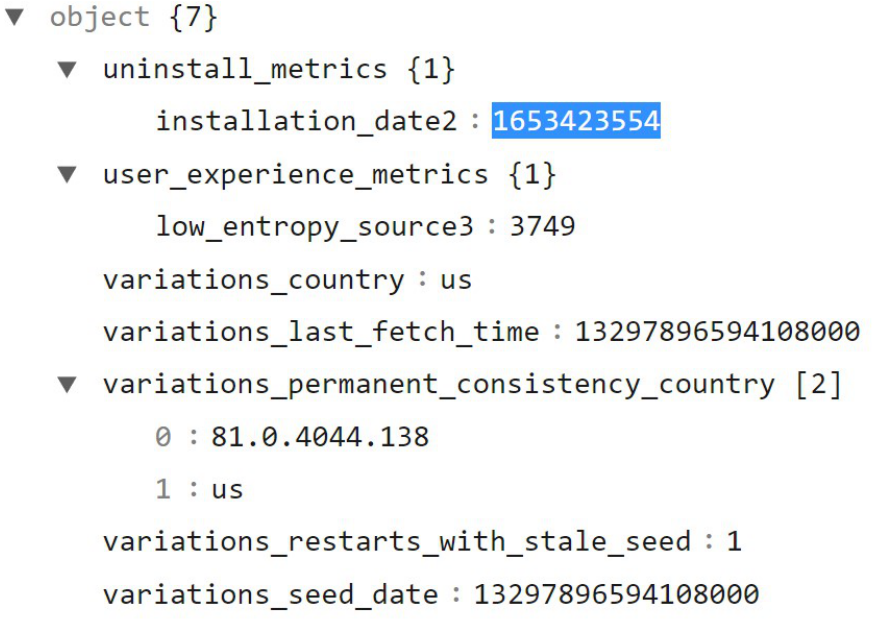
Figure 21. App installation